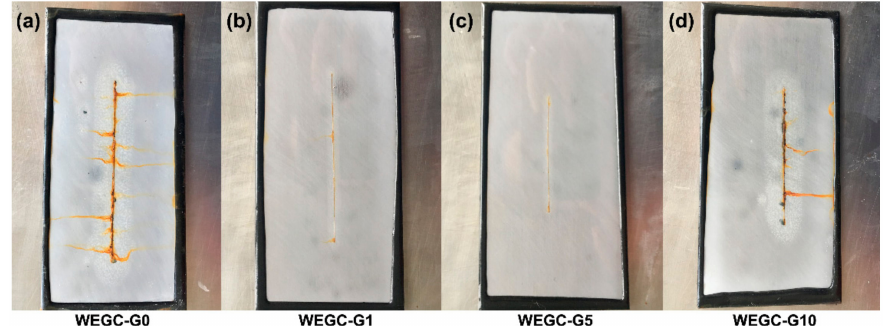
Figure 7. The images of samples after 300 h of exposure to the accelerated conditions of a salt spray